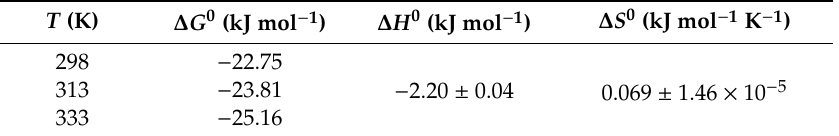
Table 5. Thermodynamic parameters for MB adsorption on rGO at di ff erent